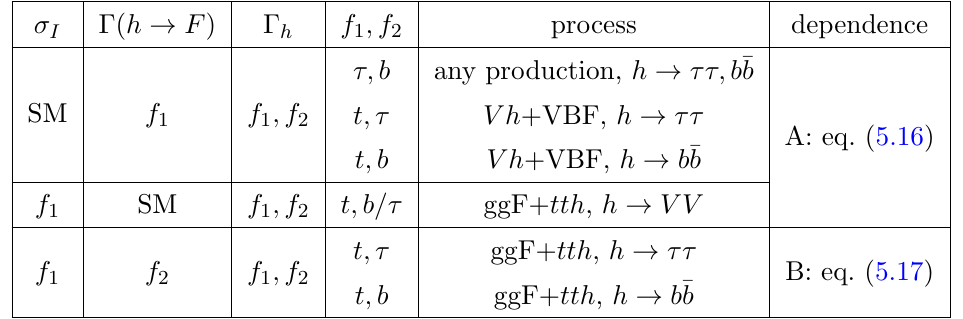
Table 1 . Possible modi(cid:12)cations of the signal strengths (cid:22) F the fermions f 1 , f 2 . The Higgs production cross section (cid:27) I , with I = V h +VBF or ggF+ tth , and/or the partial decay width (cid:0)( h ! F ), with F = f i (cid:22) f i or V V , are modi(cid:12)ed by r f particular process is not modi(cid:12)ed. The total Higgs width (cid:0) h is modi(cid:12)ed by both modi(cid:12)ed Yukawa